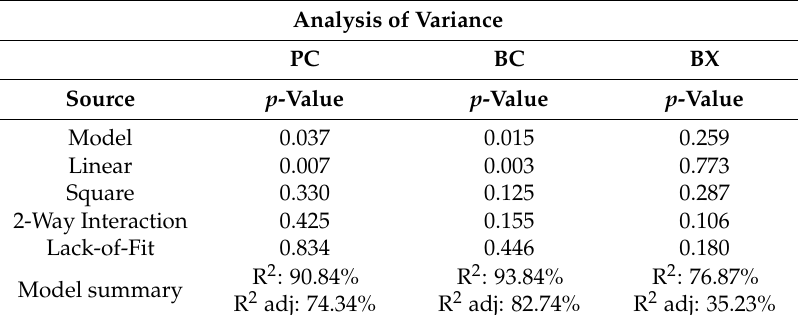
Table 3. Analysis of variance of the models for all responses of Box Behnken experimental design (BBD) for extraction of bioactive compounds from purple cactus pear fruit peel and